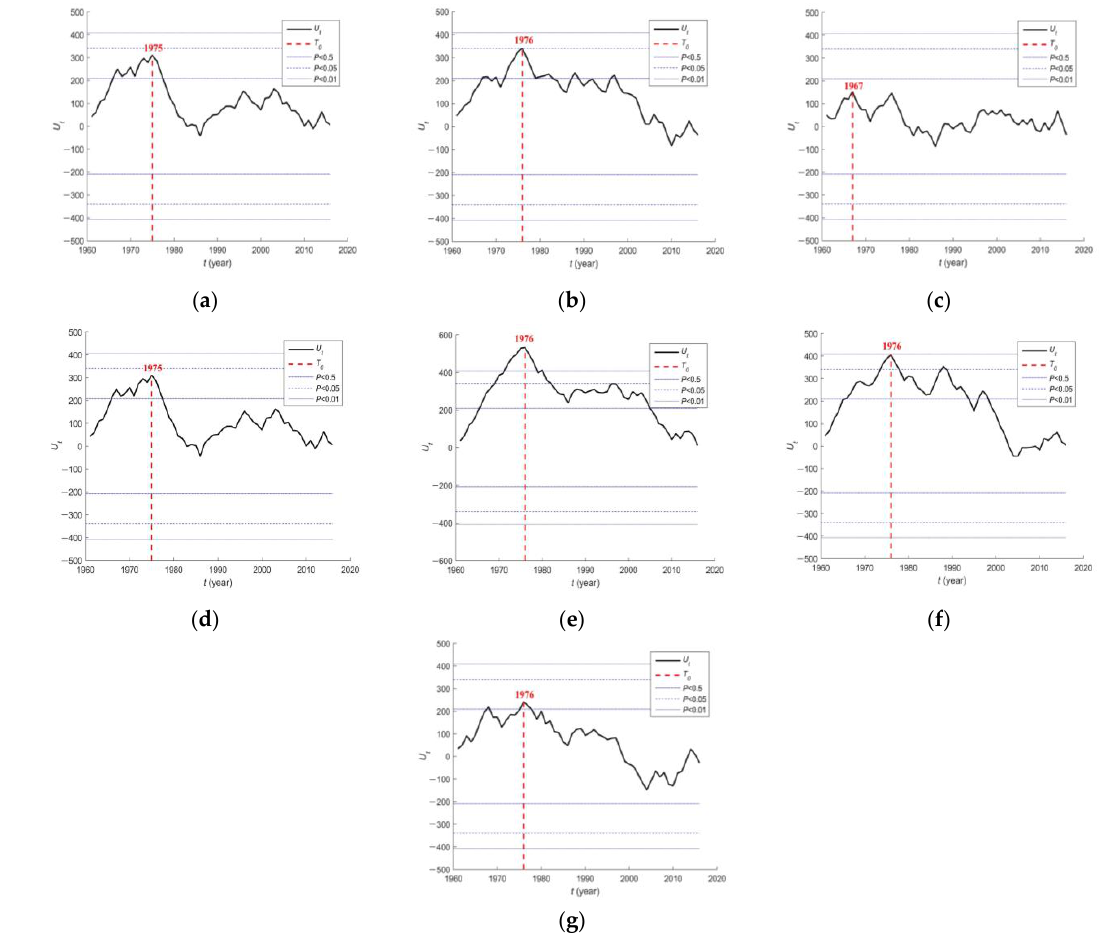
Figure 4. Results of the Pettitt mutation point test in partitions of the Changbai Mountain area. ( a ) Fengman, ( b ) Gaolichengzi, ( c ) Hanyangtun, ( d ) Quanhe, ( e ) Kaishantun, ( f ) Huanggou, and ( g ) Changbai hydrological stations.